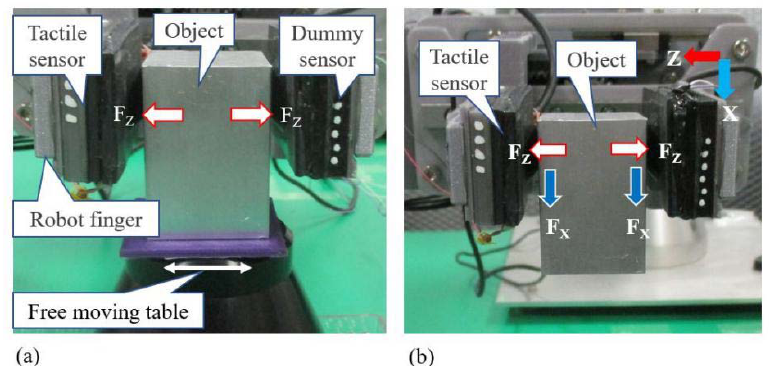
Figure 7. Photographs of the robot hand grasping and lifting the object, with the x -axis of the sensor vertical: ( a ) grasping, ( b ) lifting.